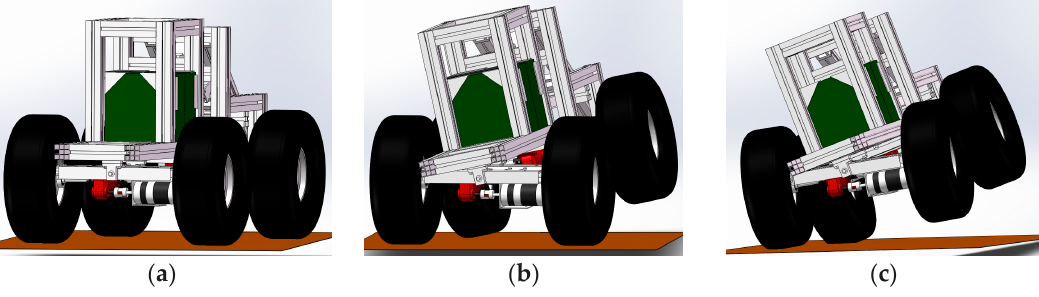
Figure 6. The lateral tilting process. ( a ) Steady state; ( b ) First stage unbalancing; ( c ) Second stage